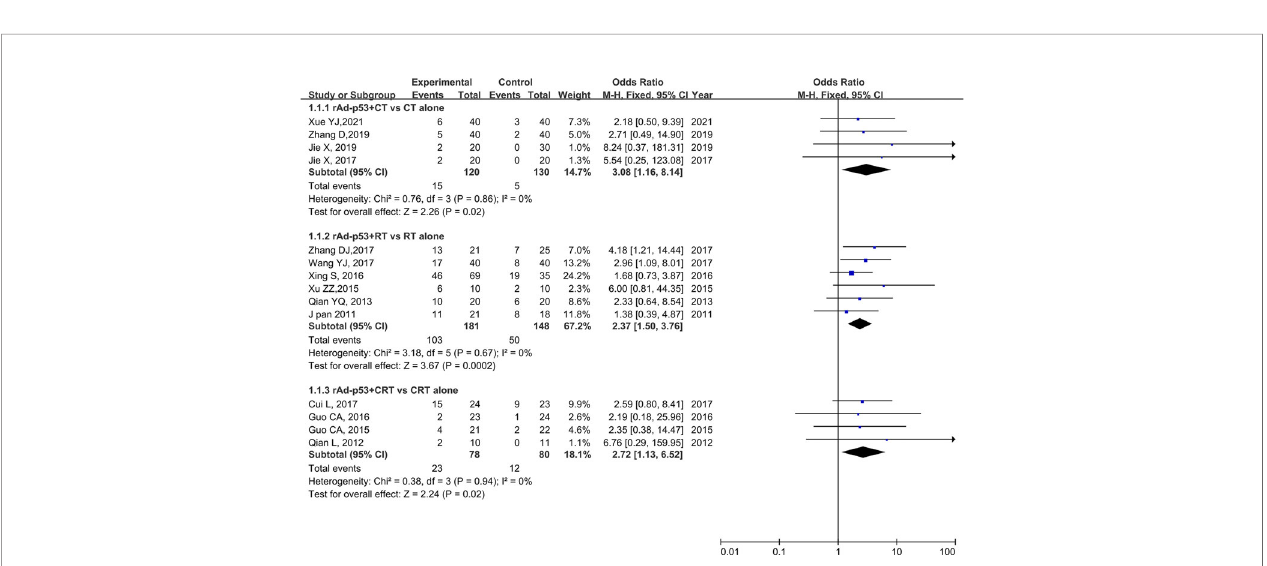
FIGURE 5 | Forest plot for subgroup analysis of CR based on CT/RT/CRT. CR: complete. CT: chemotherapy; RT: radiotherapy; CRT: chemoradiation therapy.